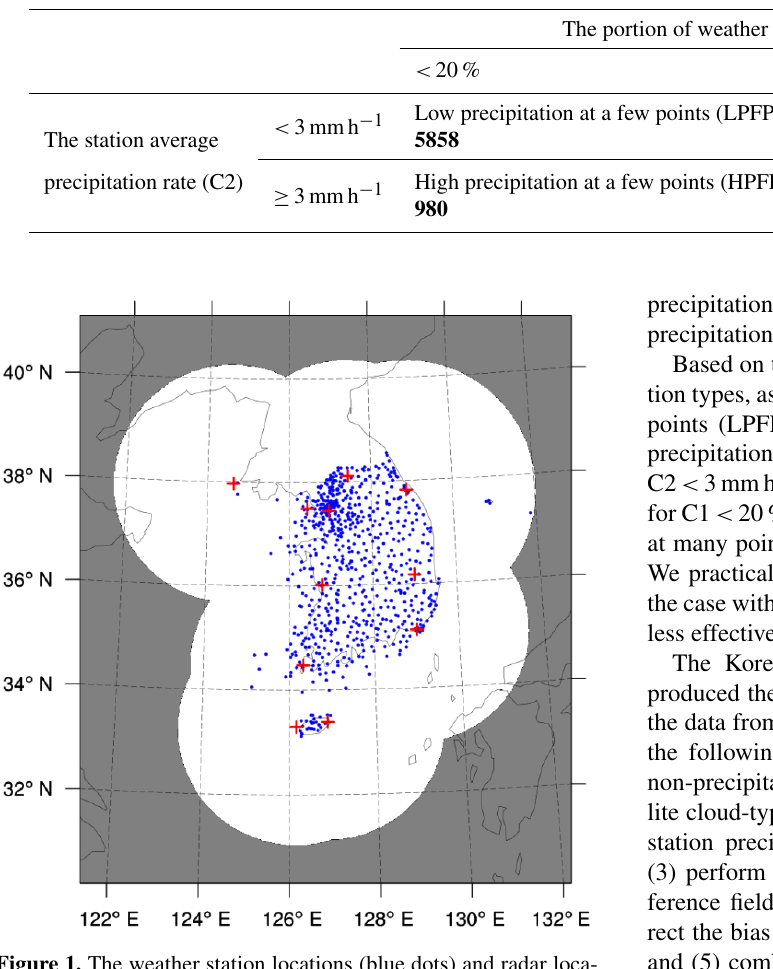
Figure 1. The weather station locations (blue dots) and radar loca- tions (red “ + ” symbols) and coverages (white area) in